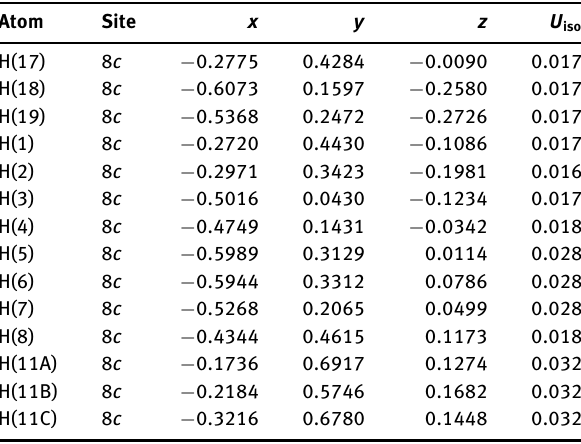
Table 2: Fractional atomic coordinates and isotropic or equivalent isotropic displacement parameters (Å 2